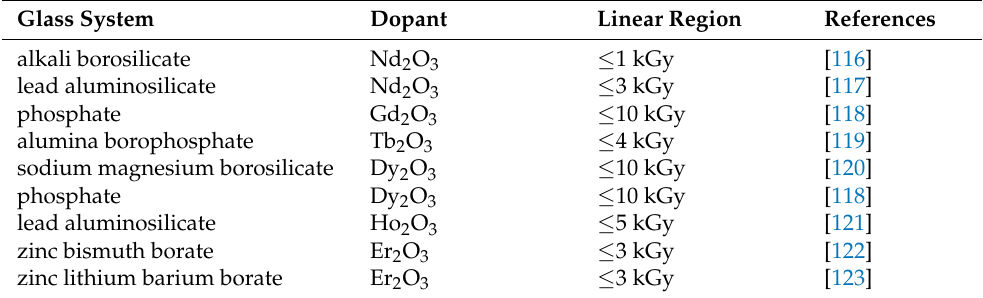
Table 1. Linear regions of thermoluminescence dose response for various glass systems.